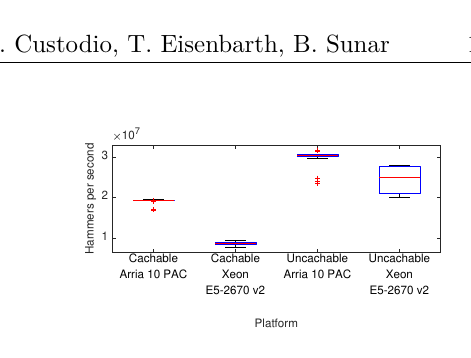
Figure 7: Distributions of hammering rates (memory requests per second) on integrated Arria 10 and Xeon E5-2600 v4.